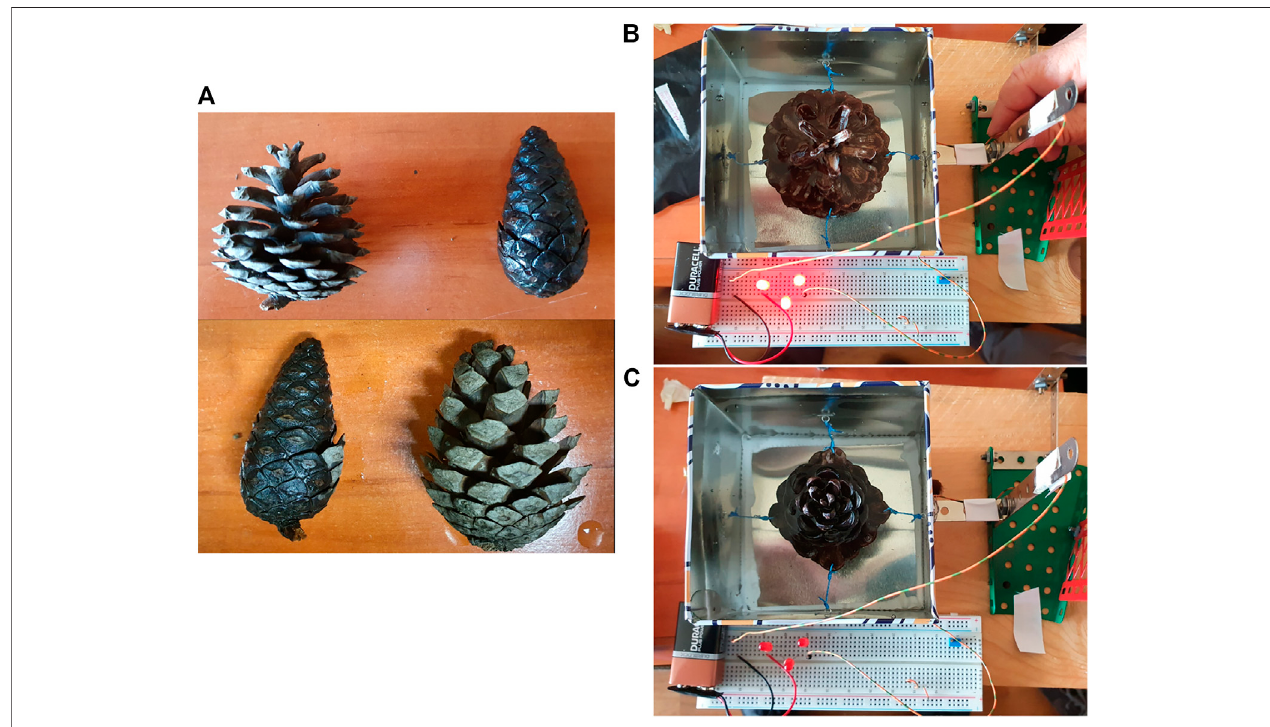
FIGURE 13 | A green actuator. (A) Opening and closing of conifer cones scales due to humidity, (B – C) actuation of an electric switch by means of a closing conifer pine.